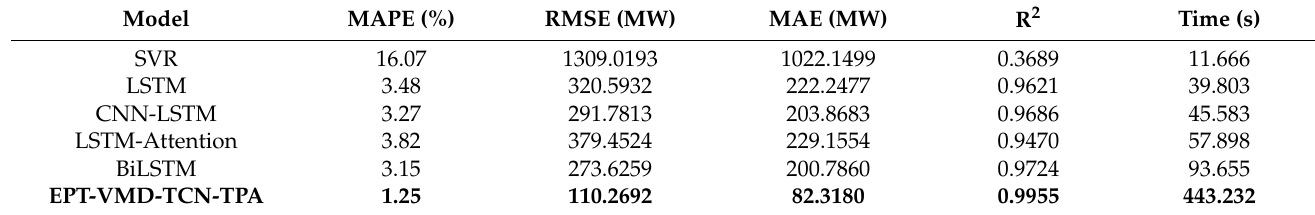
Figure 19. Area 1 classical model prediction results. Table 10. Classical model evaluation indicators for Area 1.